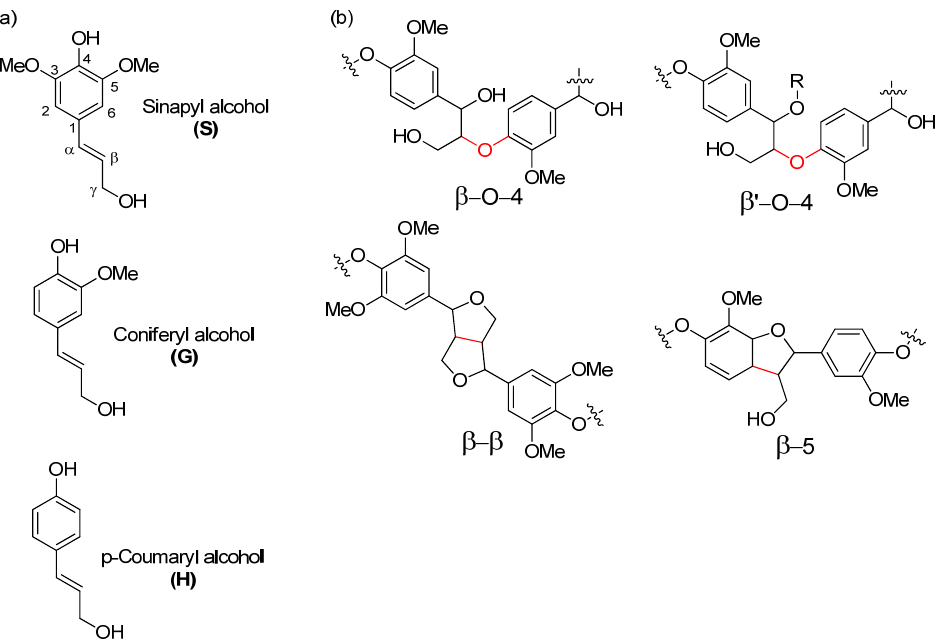
Figure 1. ( a ) Structure of the most common monolignols. ( b ) The most commonly occurring lignin linkage motifs. linkage